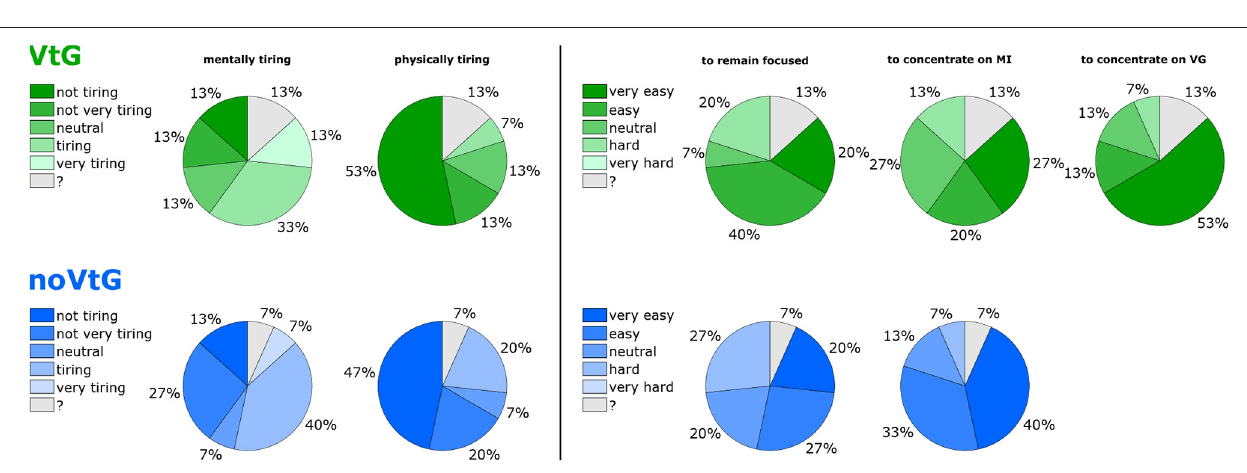
both sets of features, better results, i.e., higher mean, and lower the medians are only significantly different for spectral